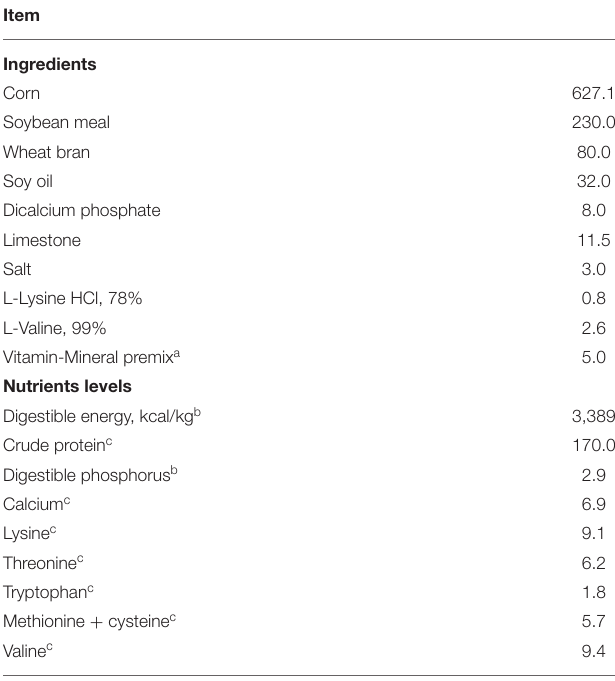
TABLE 1 | Composition and nutrient levels of basal diets (g/kg, as fed